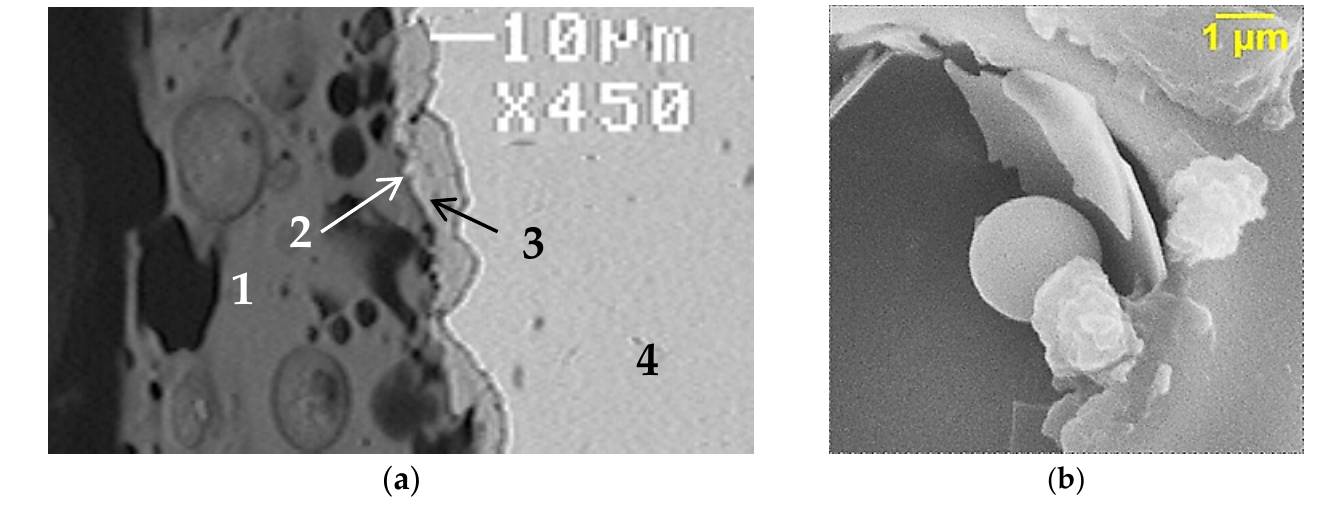
Figure 4. SEM images of the coating-steel interface formed at 820 °C ( a ) and the trace from a ball impact (6 J) on the surface of the coating obtained at 850 °C ( b ), the elemental composition corre- sponding to points 1-4 is shown in Table 4.